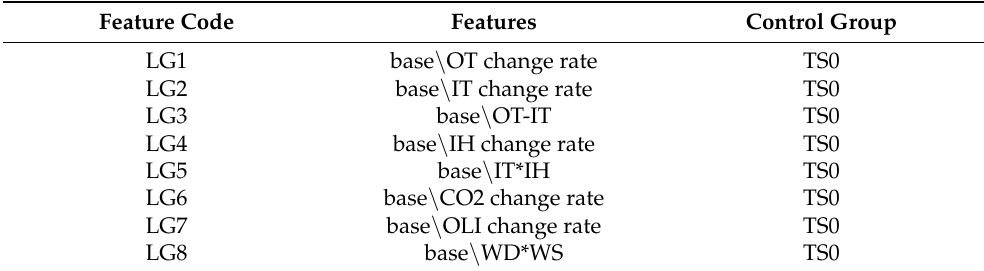
Table 5. Logic feature